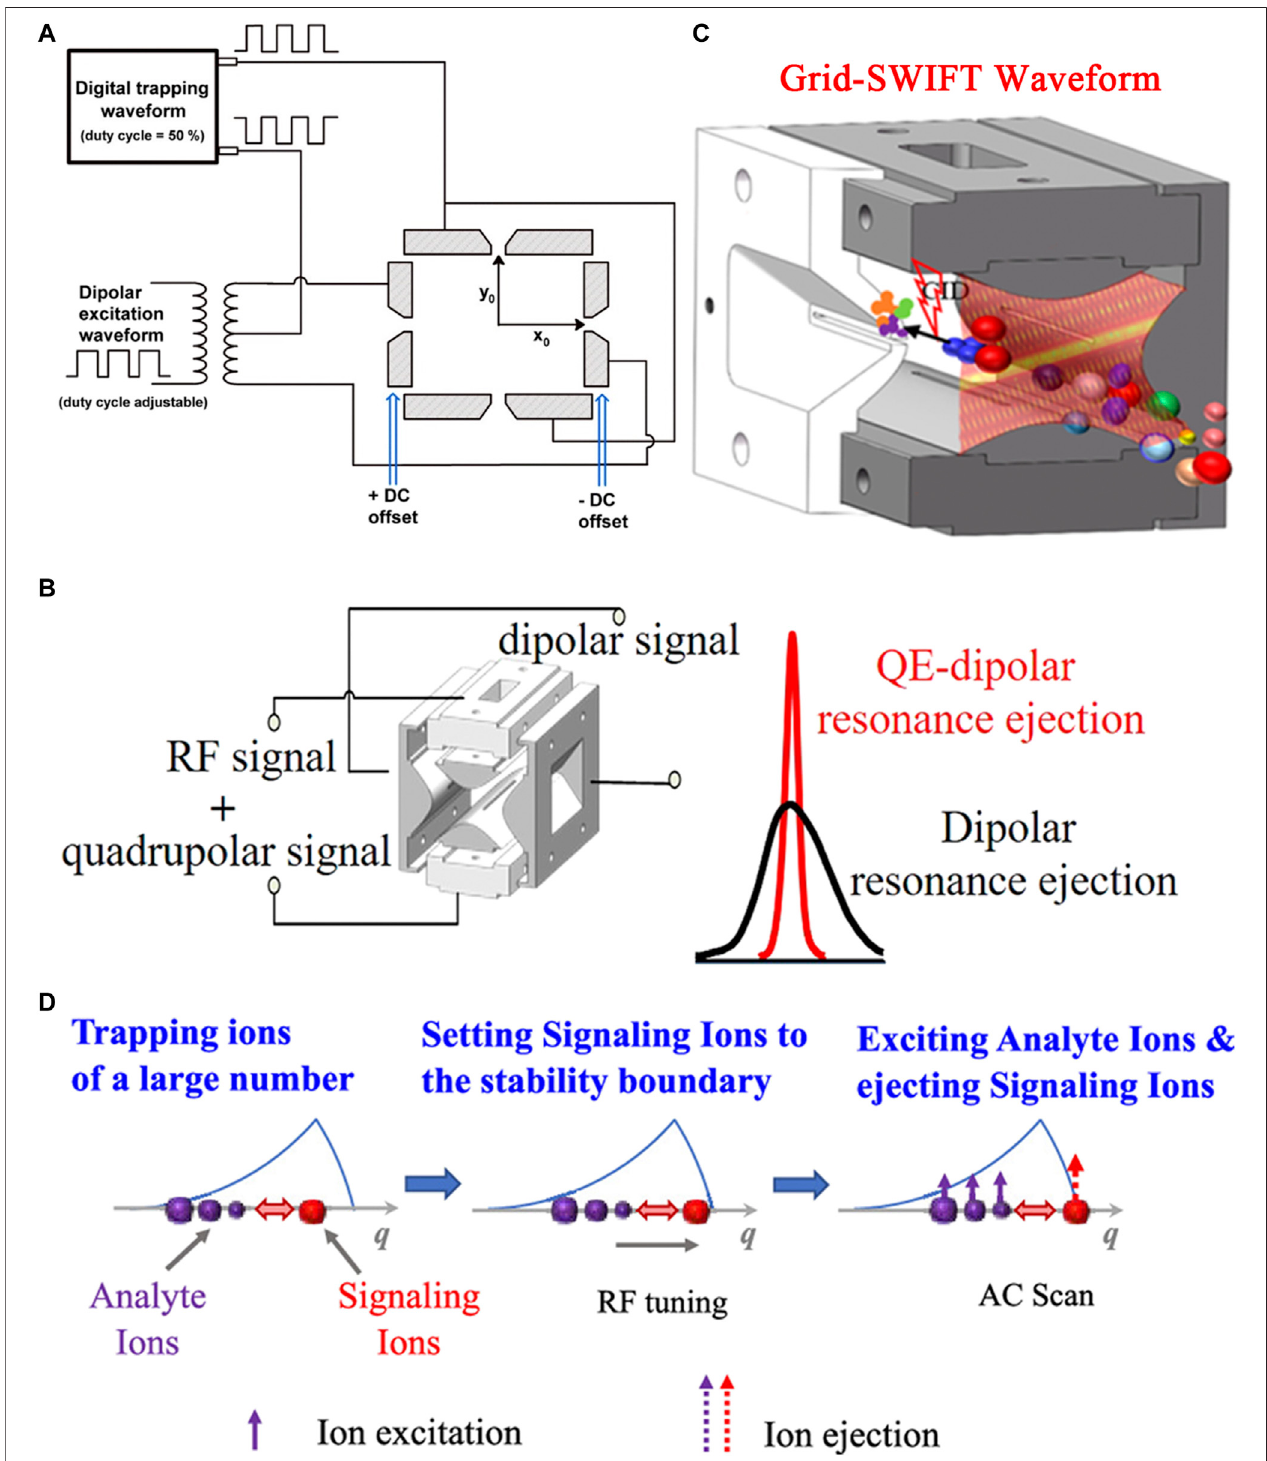
FIGURE1| Waveformappliedontheiontrap. (A) Schematicofcircuitforaceramic-basedlineariontrap(cRIT).AdaptedwithpermissionfromWang,L.,Xu,F.and Ding,C.-F(2013).Anal.Chem.85,1,271 – 1,275(Wang,etal.,2013).Copyright2013AmericanChemicalSociety; (B) SchematicdiagramofLITappliedsignal.Adapted withpermissionfrom Jiang, T., Xu, Q., Zhang, H.J., Li, D. Y. and Xu, W (2018). Anal. Chem. 90, 11,671 – 11,679 (Jiang et al., 2018).Copyright 2018 American Chemical Society; (C) The Grid-stored waveform inverse Fourier transform (Grid-SWIFT) waveform in the “ brick ” MS. Adapted with permission from Xu, Z. Q., Jiang, T., Xu, Q., Zhai, Y. B., Li, D. Y. and Xu, W. (2019). Anal. Chem. 91, 13,838 – 13,846 (Xu et al., 2019). Copyright 2019 American Chemical Society; (D) Schematic illustration for mass analysis using collective interaction. Adapted with permission from Zhou, X. and Ouyang, Z (2021). Anal. Chem. 93, 5,998 – 6,002 (Zhou and Ouyang, 2021). Copyright 2021 American Chemical Society.